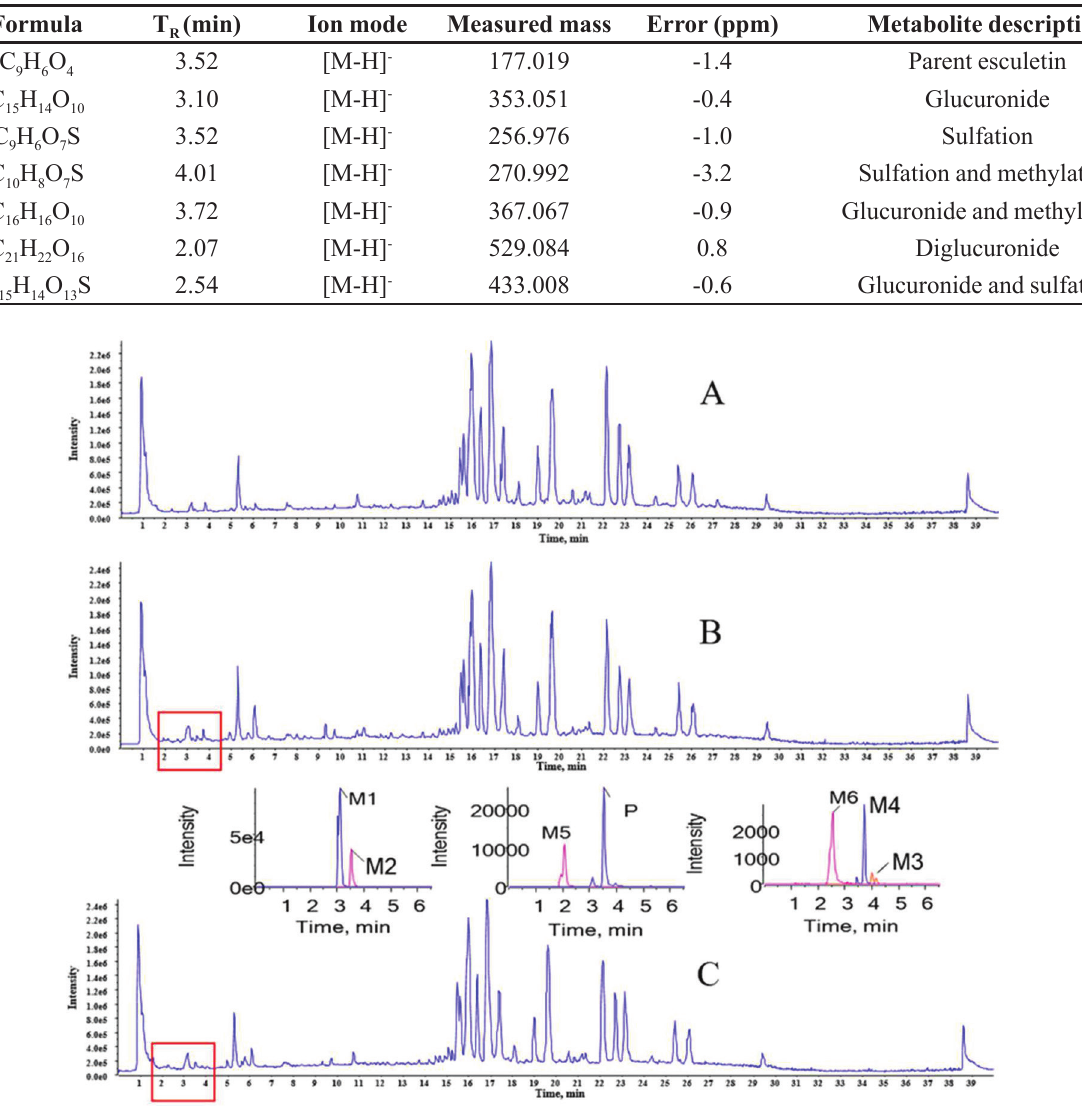
H O ; M1: glucuronide metabolite C 9 6 4 H O S; M4: glucuronide and methylation metabolite C 10 8 7 H O 15 14 13